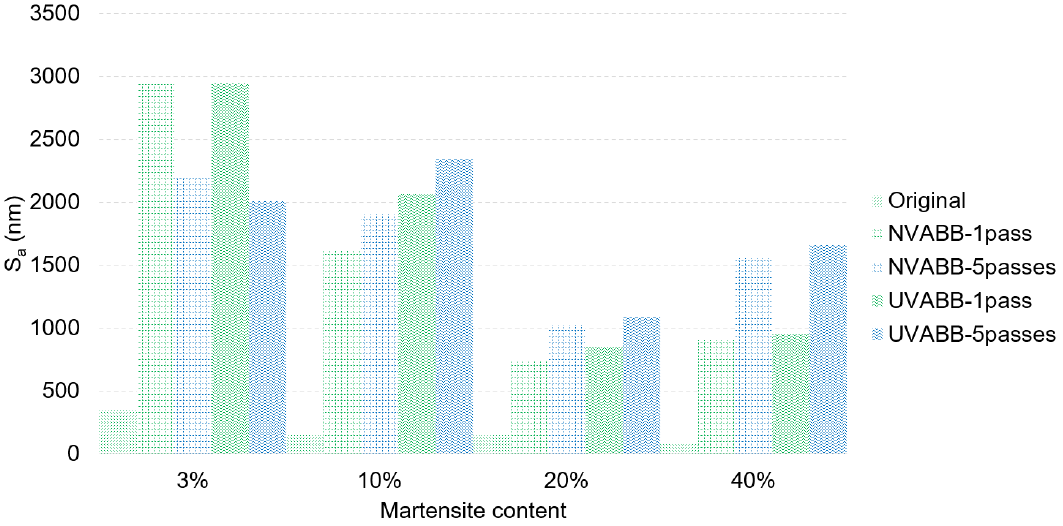
Figure 4. Average surface texture amplitude for the tested specimens burnished in the transverse